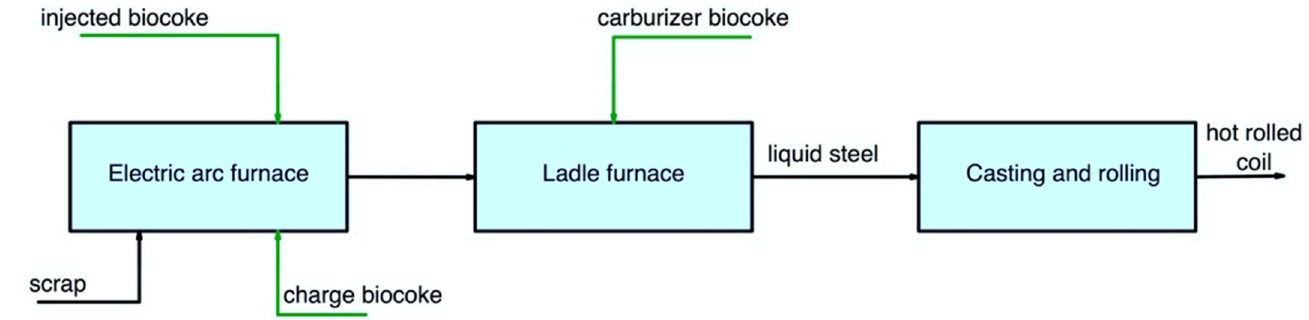
Figure 5. Main pathways for using secondary carbon bio-carriers in the EAF, where scrap is used as the main raw material.